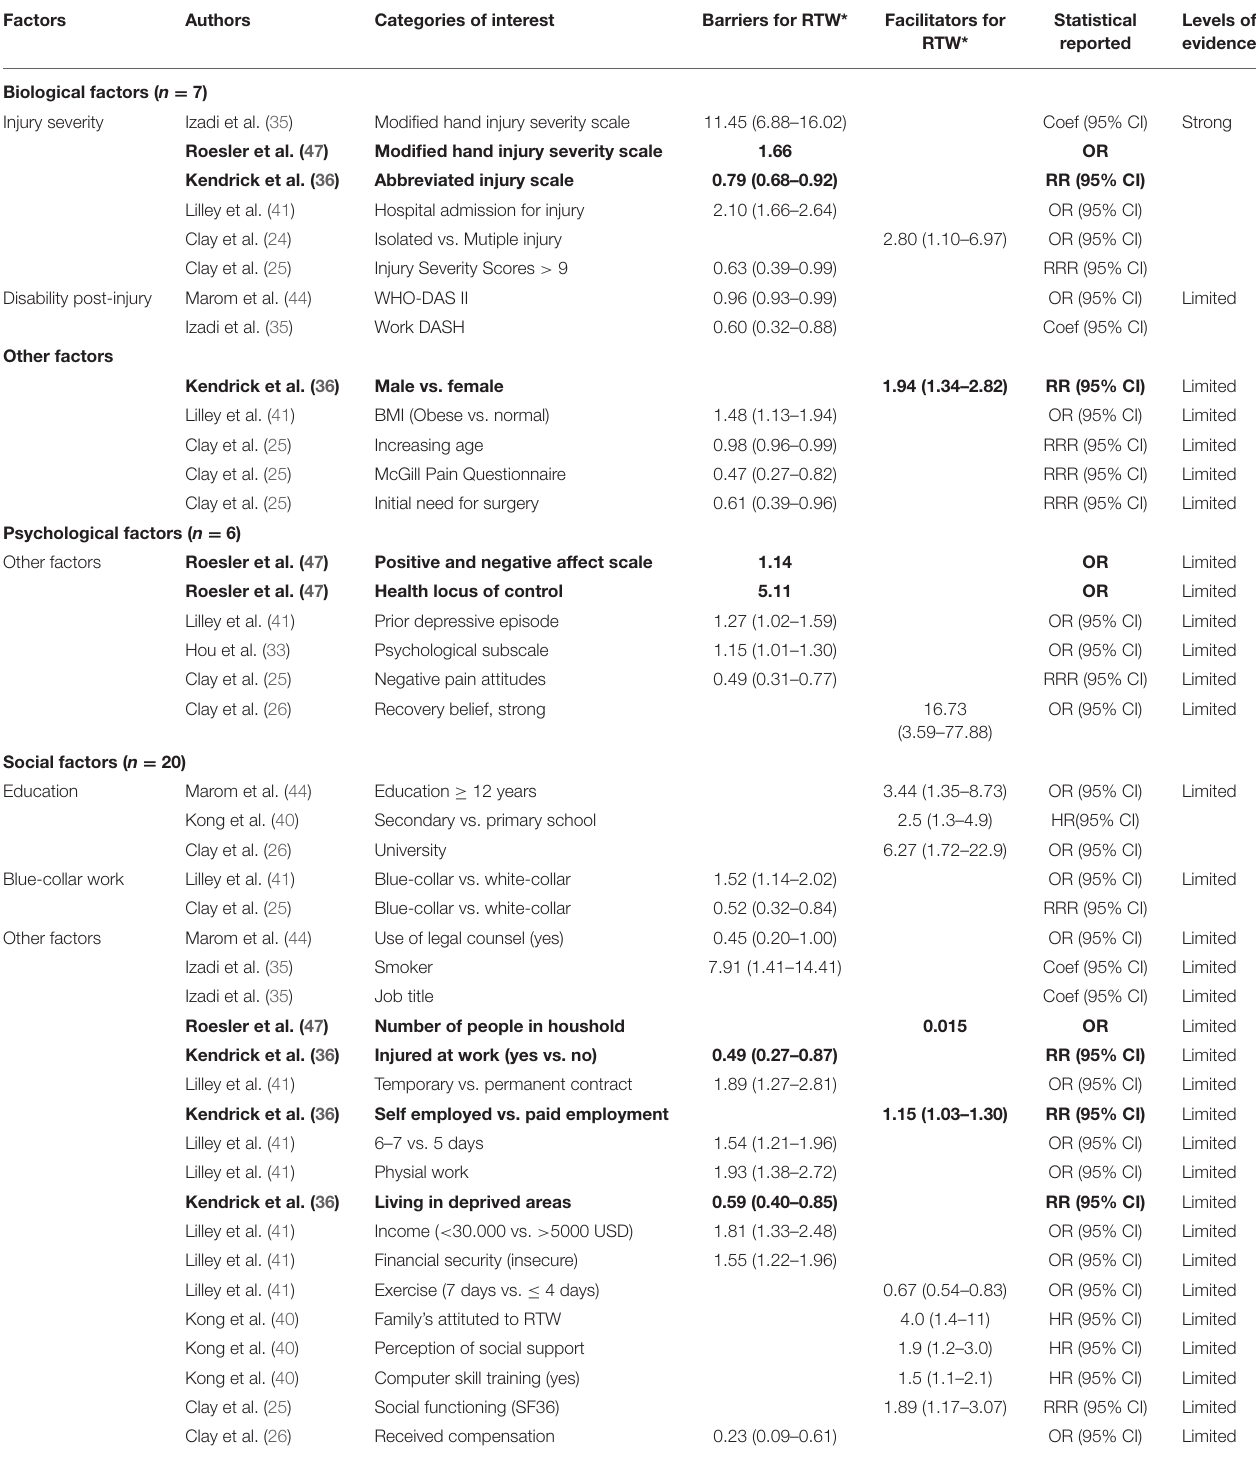
TABLE 3 | Barriers and facilitators for RTW in the early phase ( ≤ 6 months)